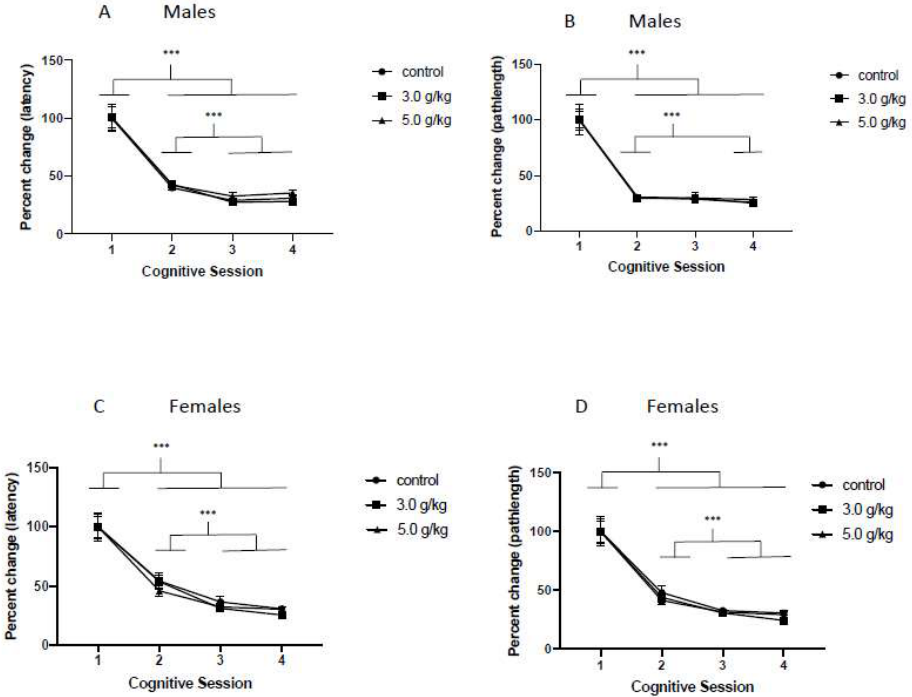
Figure 3. Chronic Intermittent Ethanol Exposure During Adolescence Does Not Impair Nonspatial Learning. Percent performance in the nonspatial tests for each cognitive session for males ( A , B ) and females ( C , D ) when measured by either latency to the platform ( A , C ) or swimpath to the platform ( B , D ). Brackets indicate significant post hoc tests while error bars denote standard error of the mean. *** denotes significant difference, p < 0.0001. A value above 100% indicates impaired performance relative to performance in CS1 while a value below 100% indicates improved performance relative to performance in CS1.